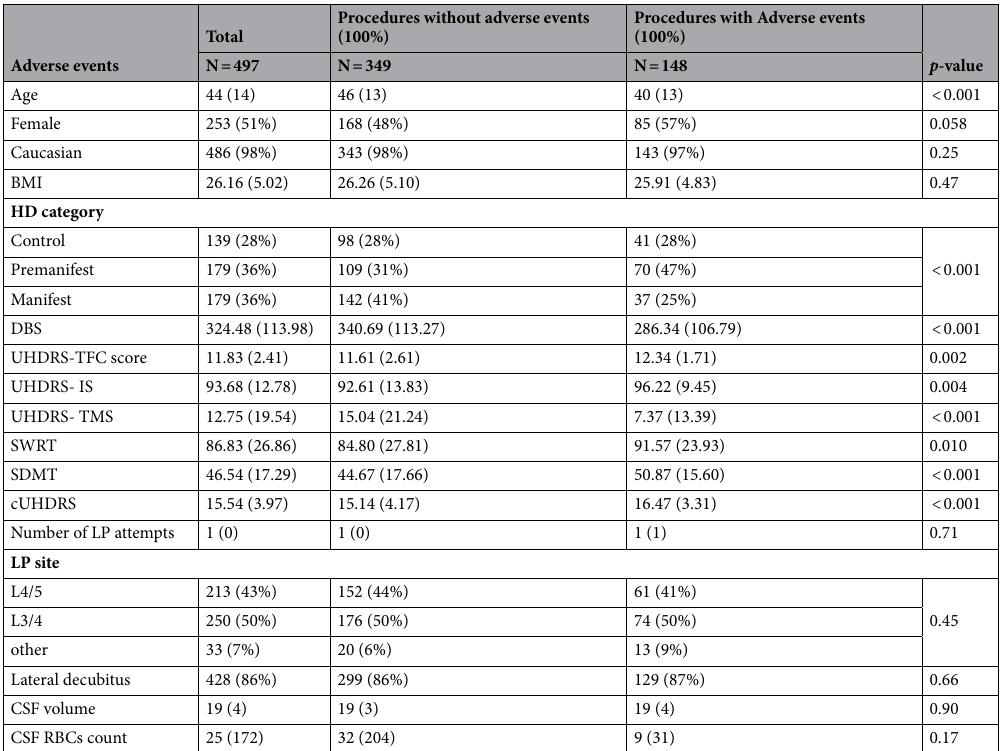
Table 3. Baseline demographics and CSF sample methodology in relation to the development of adverse events. Continuous variables are reported as mean (standard deviations). Categorical variables are reported as absolute and relative frequencies. BMI body mass index, CAG HTT CAG size, DBS Disease Burden Score, cUHDRS composite Unified Huntington’s Disease Rating Scale, TMS UHDRS Total Motor Score, TFC UHDRS Total Functional Capacity, IS UHDRS Independence Scale, SWR Stroop Word Reading test, SDMT Symbol Digits Modality Test, RBCs Red Blood